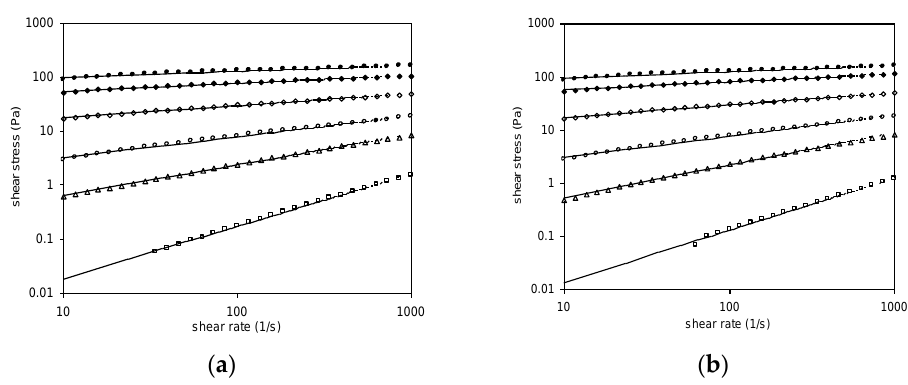
Figure 4. Effect of Yanang gum concentration on the steady-shear viscosity at 25 °C. (  ) 0 . 10%, (  ) 0 . 25%, (  ) 0 . 50%, (  ) 1 . 00%, (  ) 1 . 50%, ( • ) 2 . 00% .